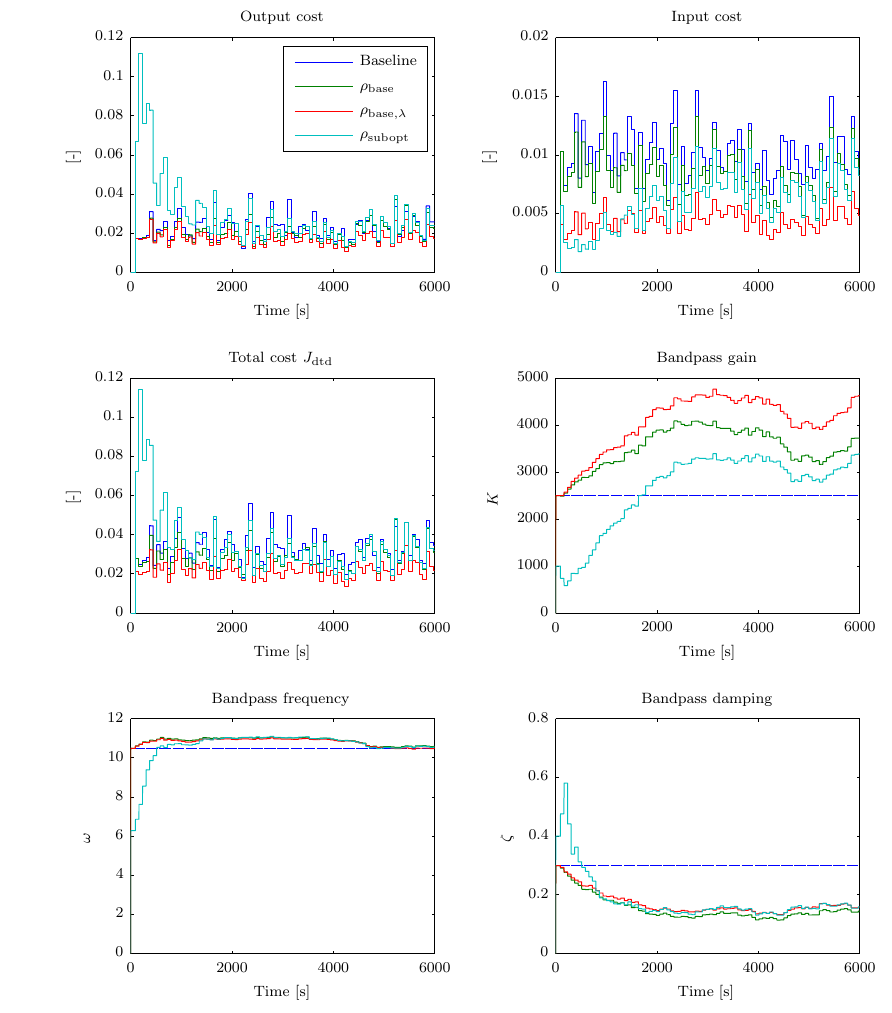
Figure 9. Comparison of three drivetrain torsional damping controllers, two of which are subject to IFT. The baseline controller parameters are kept constant and the result is shown as reference. The other three cases involve IFT, where the torsional damper is optimized starting from different initial conditions. Results shown are obtained with γ = 0 . 3, F = 2000, and turbulent wind with mean speed 14ms − 1 and 10% turbulence